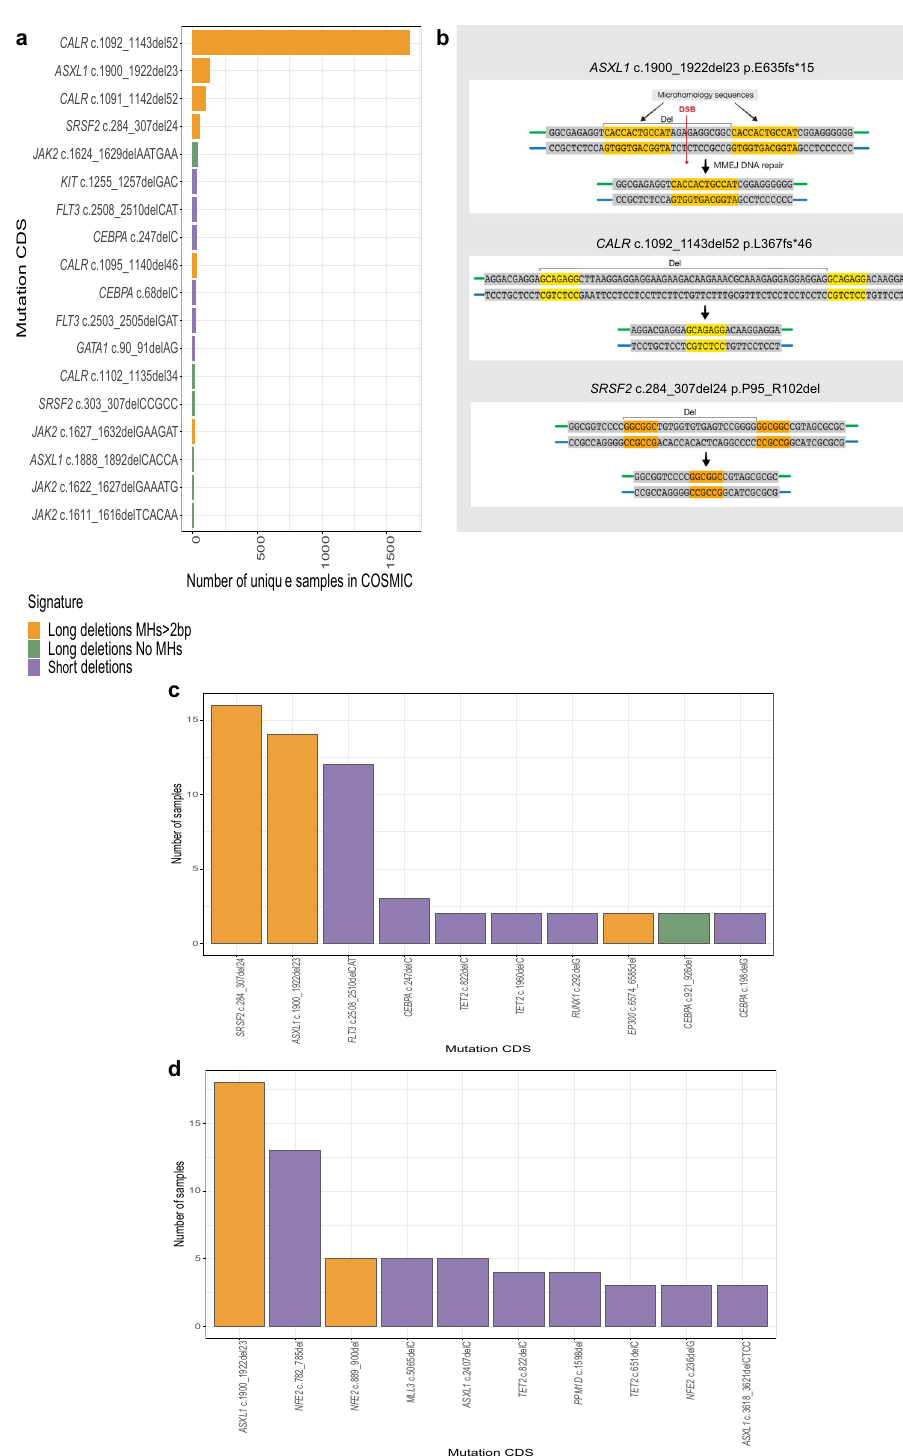
Fig. 1 Most common deletions in myeloid malignancies share an MH-based signature. a Number of samples carrying somatic deletion (represented by gene and mutation CDS (coding DNA sequence) names) in myeloid malignancies from COSMIC dataset. Deletions that were identi fi ed in 10 or more unique samples are shown. Deletion signatures are: long ( ≥ 5-bp) deletions with fl anking microhomologies (MHs) of at least 2 bp (orange), long ( ≥ 5-bp) deletions with fl anking MHs of zero or 1 bp (green) and short deletions (<5-bp) (purple). A single base mismatch was allowed. b MH-based deletion signature in ASXL1 , CALR and SRSF2 genes. Upon double-strand break (DSB) (red arrow) at genomic loci located between two MH sequences (orange and yellow), DNA repair (vertical black arrow) involves a deletion (Del) of one MH and the sequence between the two MHs. c , d Number of samples carrying the 10 most common somatic deletions (represented by gene and mutation CDS (coding DNA sequence) names) in 1540 adult acute myeloid leukemia ( c ) and 2045 Myeloproliferative neoplasm ( d ) datasets. Deletion signatures are as described in a. Source data are provided as a Source Data fi